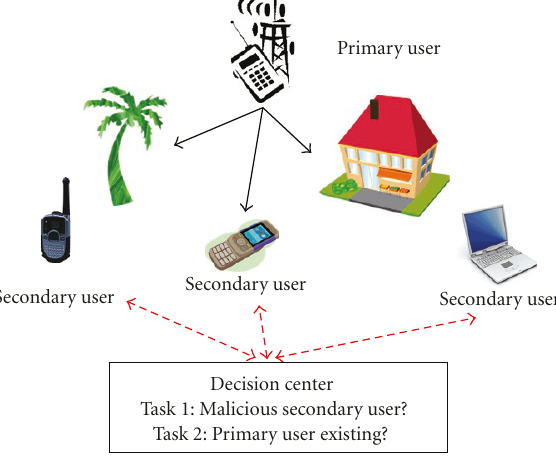
Figure 1: Collaborative spectrum